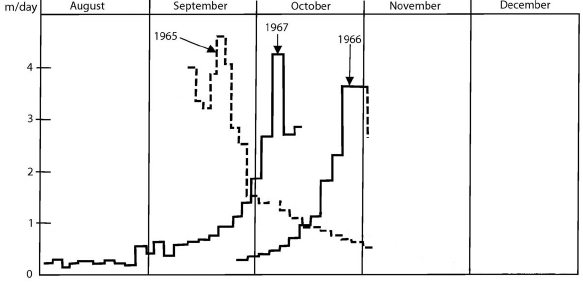
Fig. 10. Glacier motion following the 1965 active phase at Allal- ingletscher (dashed line) and active phases measured the next two years (solid lines) (R¨othlisberger,